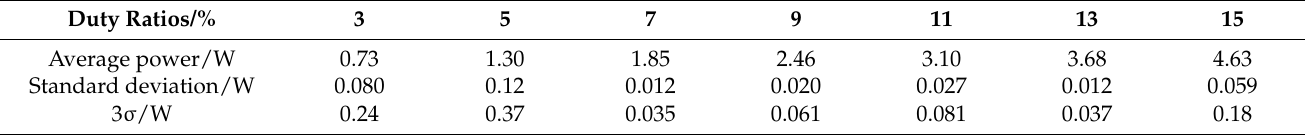
Table 3. Actual average power under different duty cycles (effective measurement time 2.4 S).